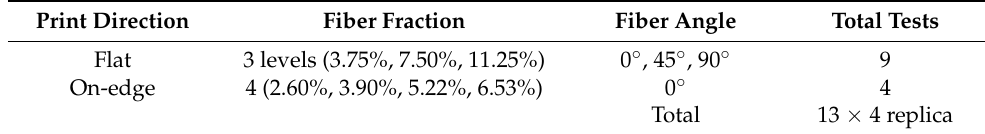
Table 1. DOE information using three factors.